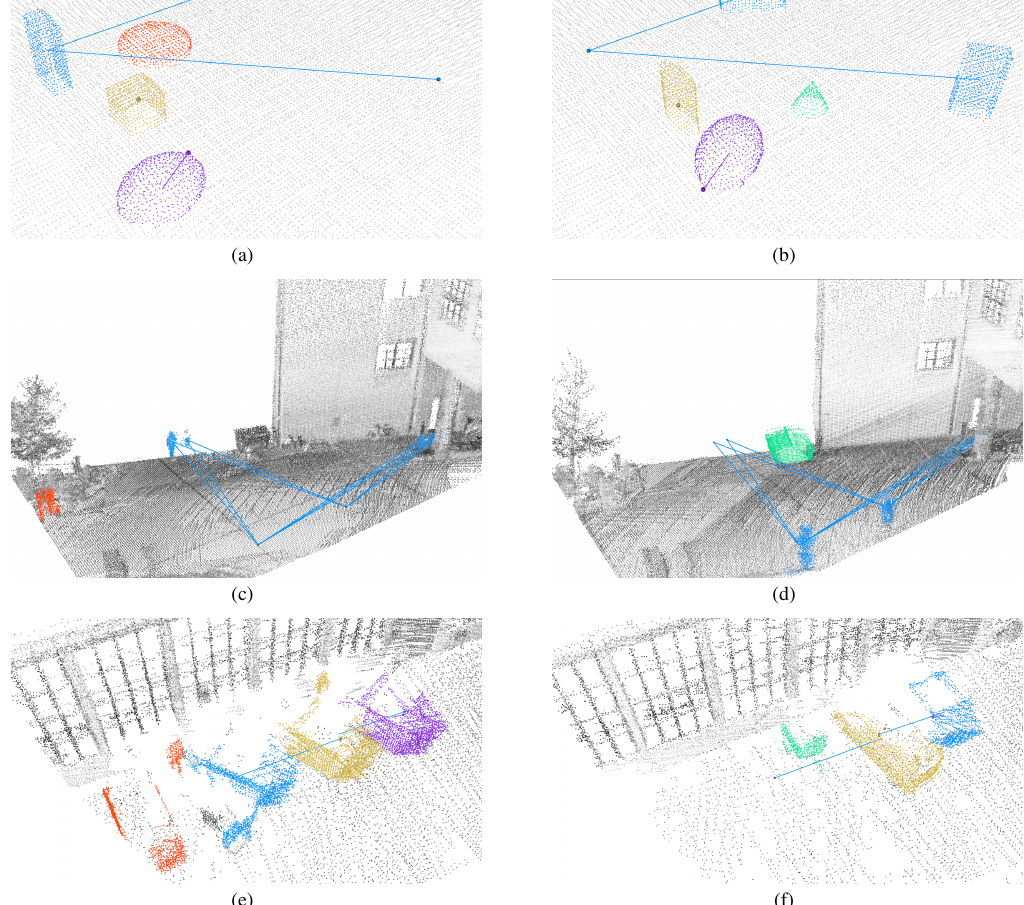
Figure 7. The demo scene from the synthetic dataset with two epochs (a) and (b). Two scenes (c,d) and (e,f) with two epochs from the TUM City campus datasets. The classes appeared (green), disappeared (red), partially moved (purple), fully moved (blue) and deformed (gold) are shown. Lines symbolize associations of object instances between epochs.